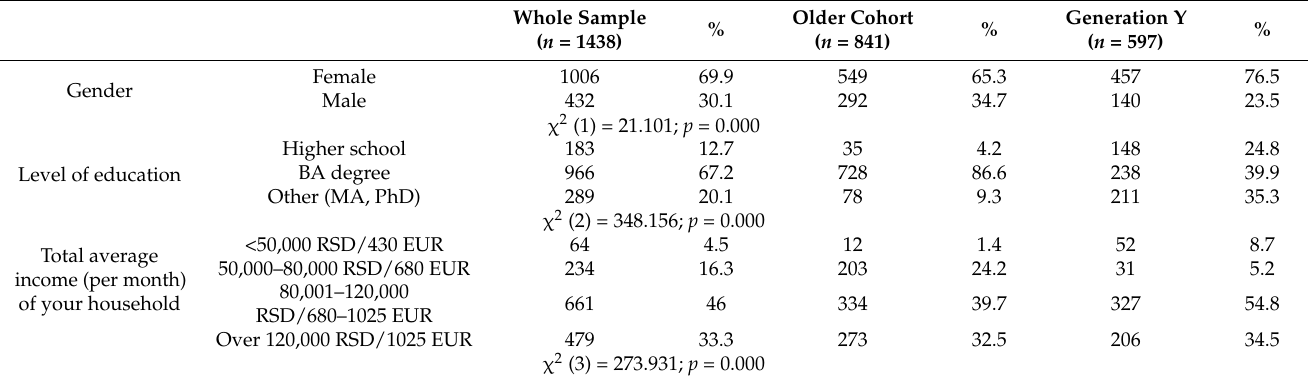
Table 1. Sample characteristics.